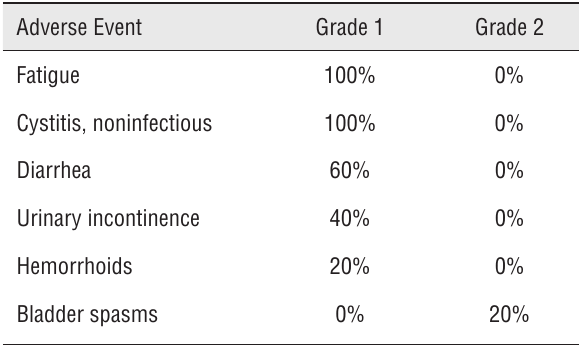
Table 1 - Common Terminology Criteria for Adverse Events version 4.0 acute urinary and gastrointestinal toxicity due to bladder-sparing